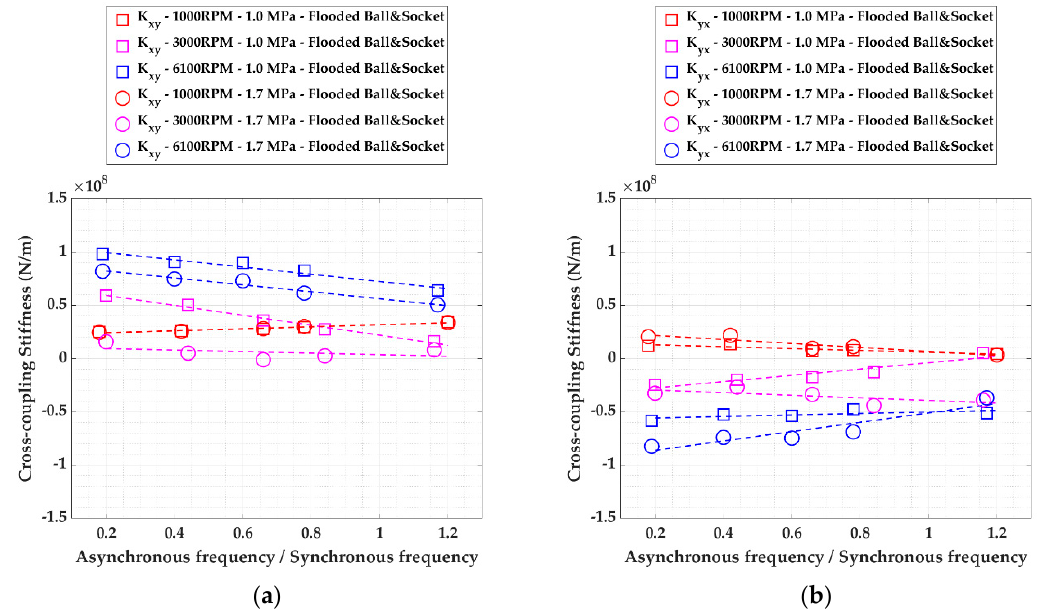
Figure A7. Flooded Ball & Socket Pivot bearing asynchronous cross-coupling coefficients at various speeds for 1.0 MPa and 1.7 MPa: ( a ) K xy , ( b ) K yx .